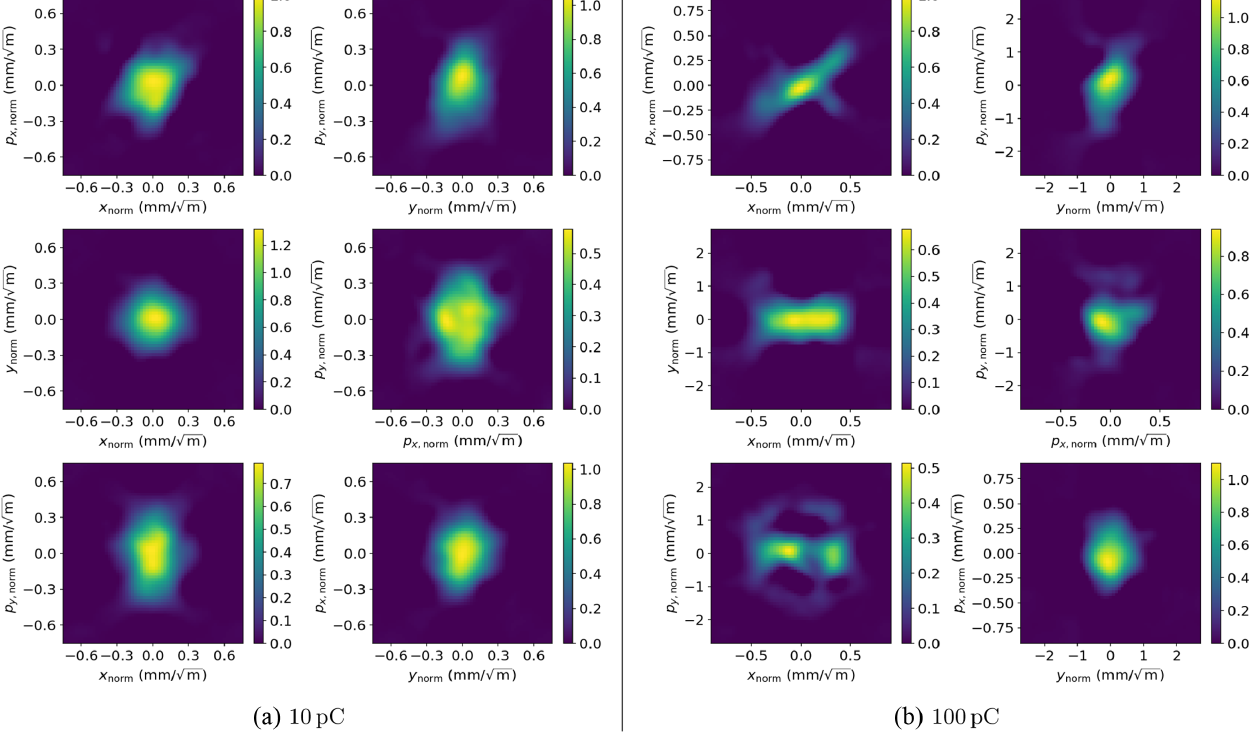
FIG. 12. Projections of the 4D phase space distribution of the beam in CLARA at the exit of the linac, for (a) 10-pC bunch charge and (b) 100-pC bunch charge, found from machine